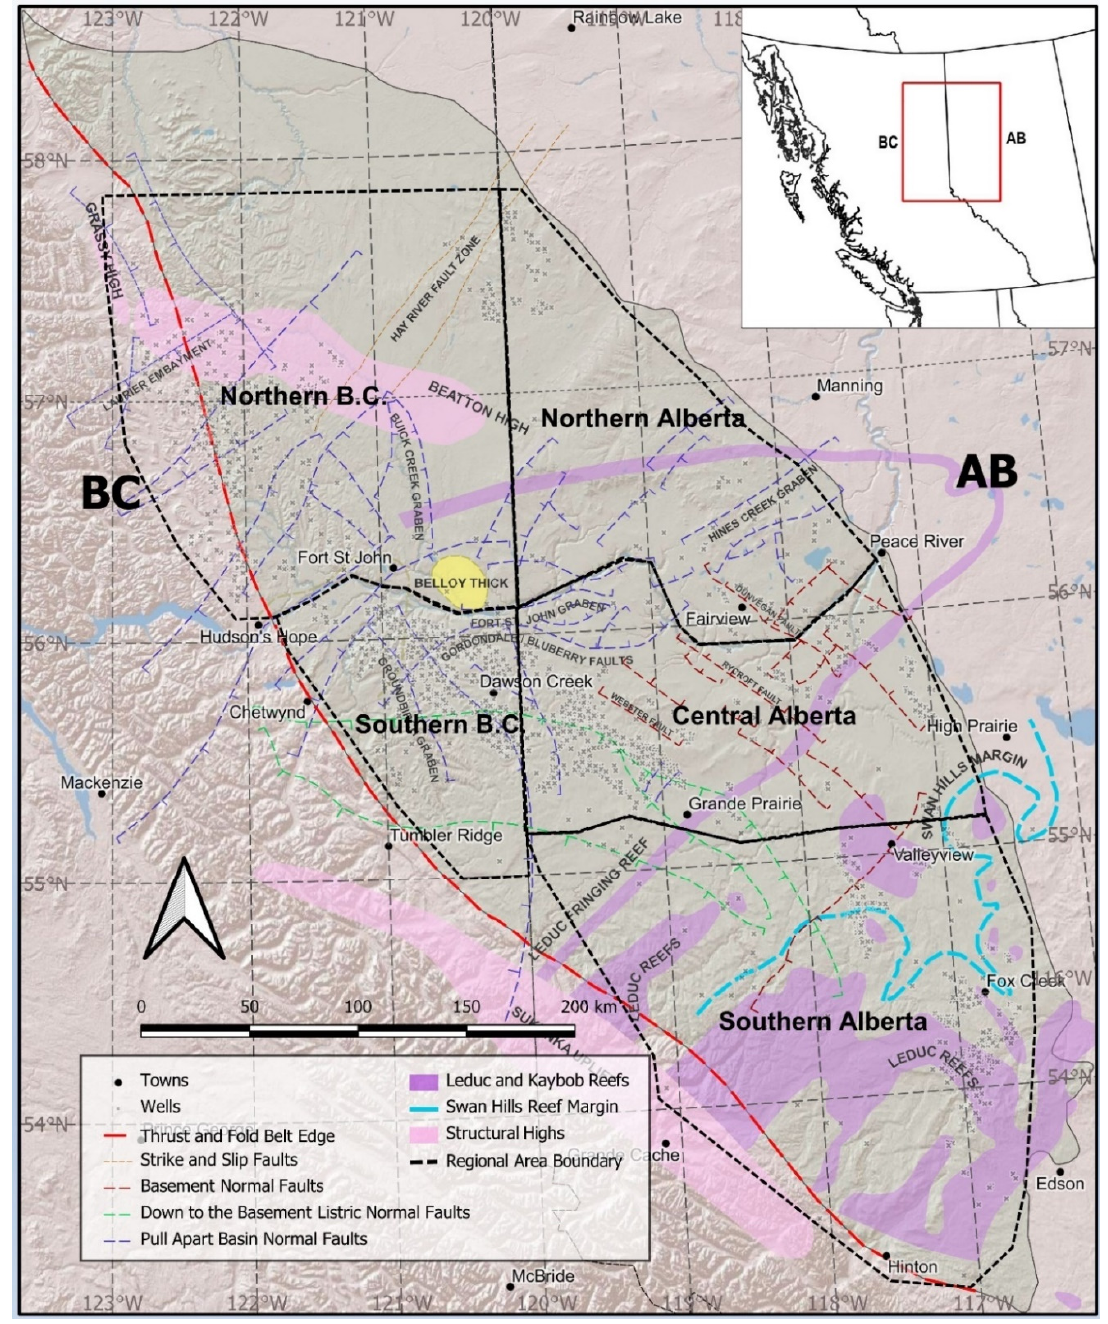
Figure 1. The location of wells sampled (cross symbol) for hydrocarbon composition and the loca- tion of the subdivided regional areas used in this study. Major structural elements that affect the deposition of the Montney Formation are also shown (modified from